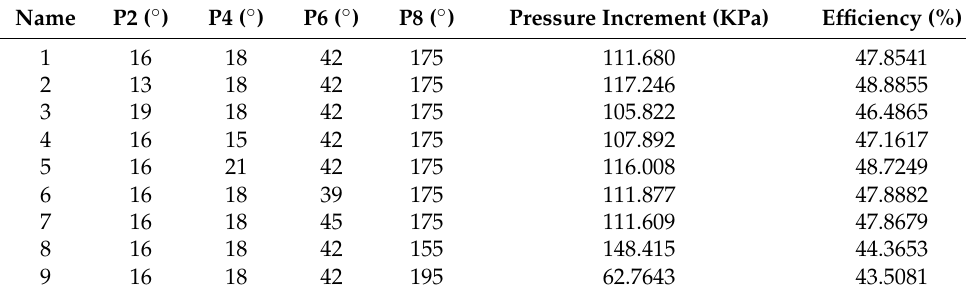
Table 4. Experimental design based on the Sparse Grid method.